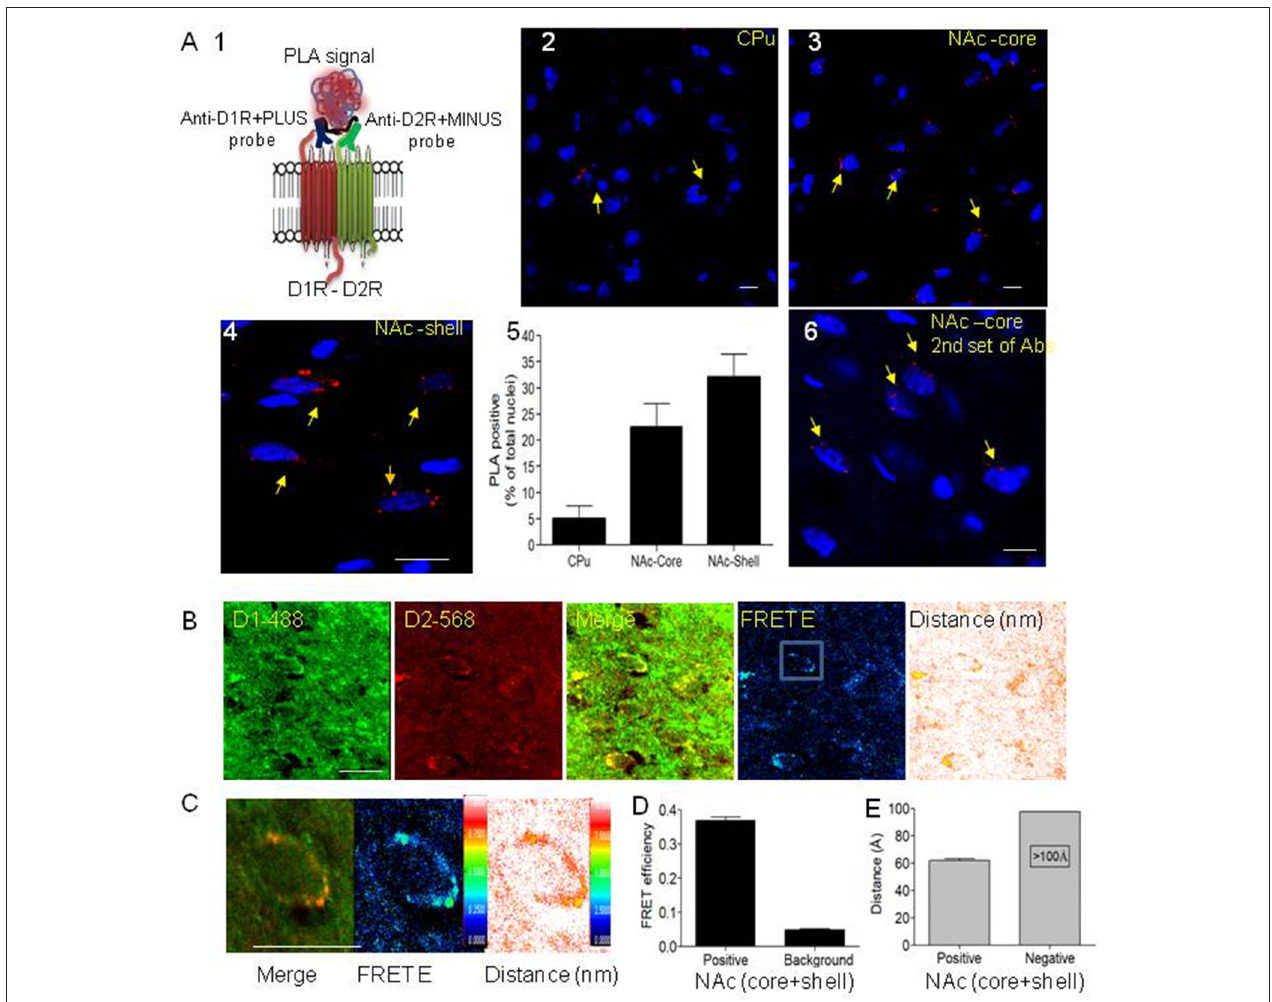
FIGURE 1 | Evidence for the existence of dopamine D1-D2 receptor heteromer in rat NAc. (A) Proximity ligation assay (PLA) was used to visualize and detect D1R and D2R close proximity. (A1) A scheme depicts the PLA probes used in the present study. (A2–A4) Representative images of PLA signals (red dots) in neurons (nuclei stained by DAPI) in rat caudate putamen (CPu), nucleus accumbens core (NAc-core) and shell (NAc-shell) subregions. (A5) Graph representing the percent of neurons with a positive PLA signal. (A6) Representative image of PLA signals in neurons (nuclei stained by DAPI) in rat NAc-core using the second set of antibodies. (B) Representative images of immunohistochemistry using D1R antibody (D1R-Ab) or D2R antibody (D2R-Ab) directly conjugated to Alexa-488 or Alexa-568, respectively, in the NAc-shell. Direct confocal FRET analysis was performed, reflected by FRET efficiency (FRET E) and the distance between the dipoles, less than 10nm (100 Å). (C) A representative close-up of a single MSN cell body from NAc showing D1R-D2R colocalization (left), D1-D2 heteromer FRET efficiency (center) and relative distance between receptors (right). (D,E) Histograms showing FRET E ratios (D) and distance (E) obtained from MSN cell bodies from NAc ( n = 24). Bars are 10 µ